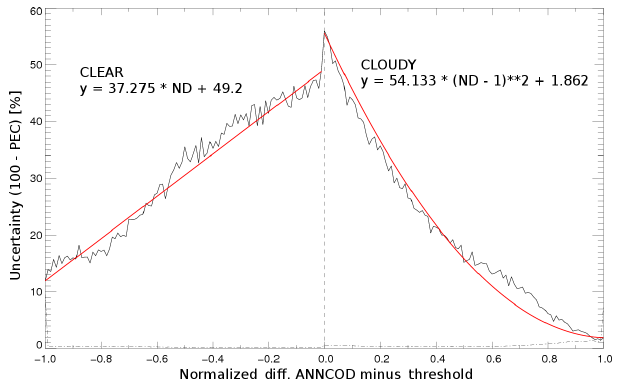
Figure 2. Neural network cloud mask uncertainty as derived from